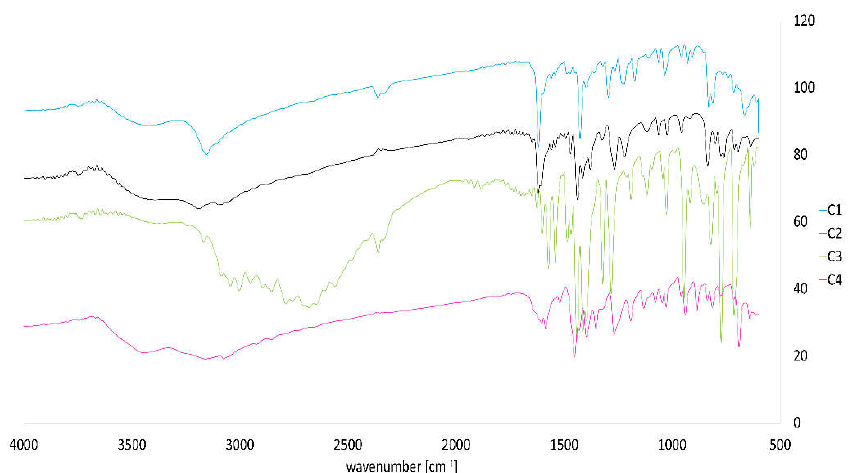
Figure 2. FTIR spectrum of copper (II) coordination compounds.